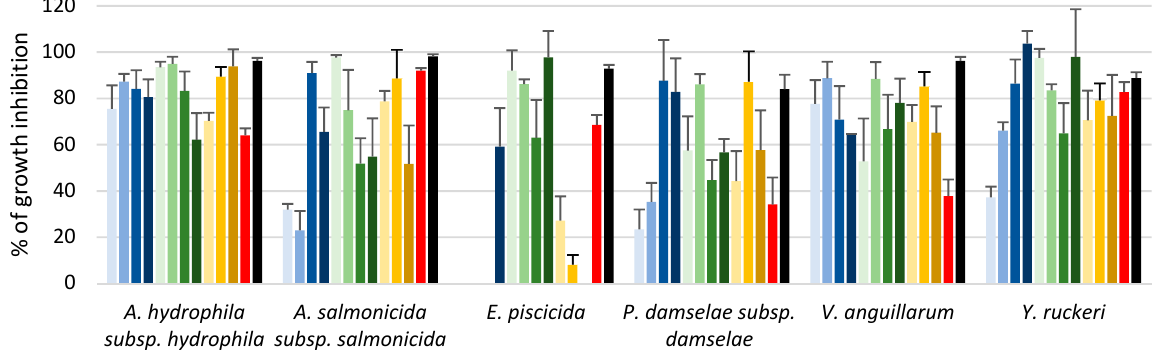
Figure 6. Growth inhibition (%) of fish pathogenic bacteria in the presence of ethanol extracts of G. gracilis in liquid media after 18 h of growth. The extracts were obtained at room temperature (RT, bars in shades of blue), 40 °C (40, bars in shades of green), or 70 °C (70, bars in shades of yellow/red) for 30 min, and chloramphenicol (CHL, black bars) was used as a positive control. Results are expressed as average values ± SD ( n = 4).